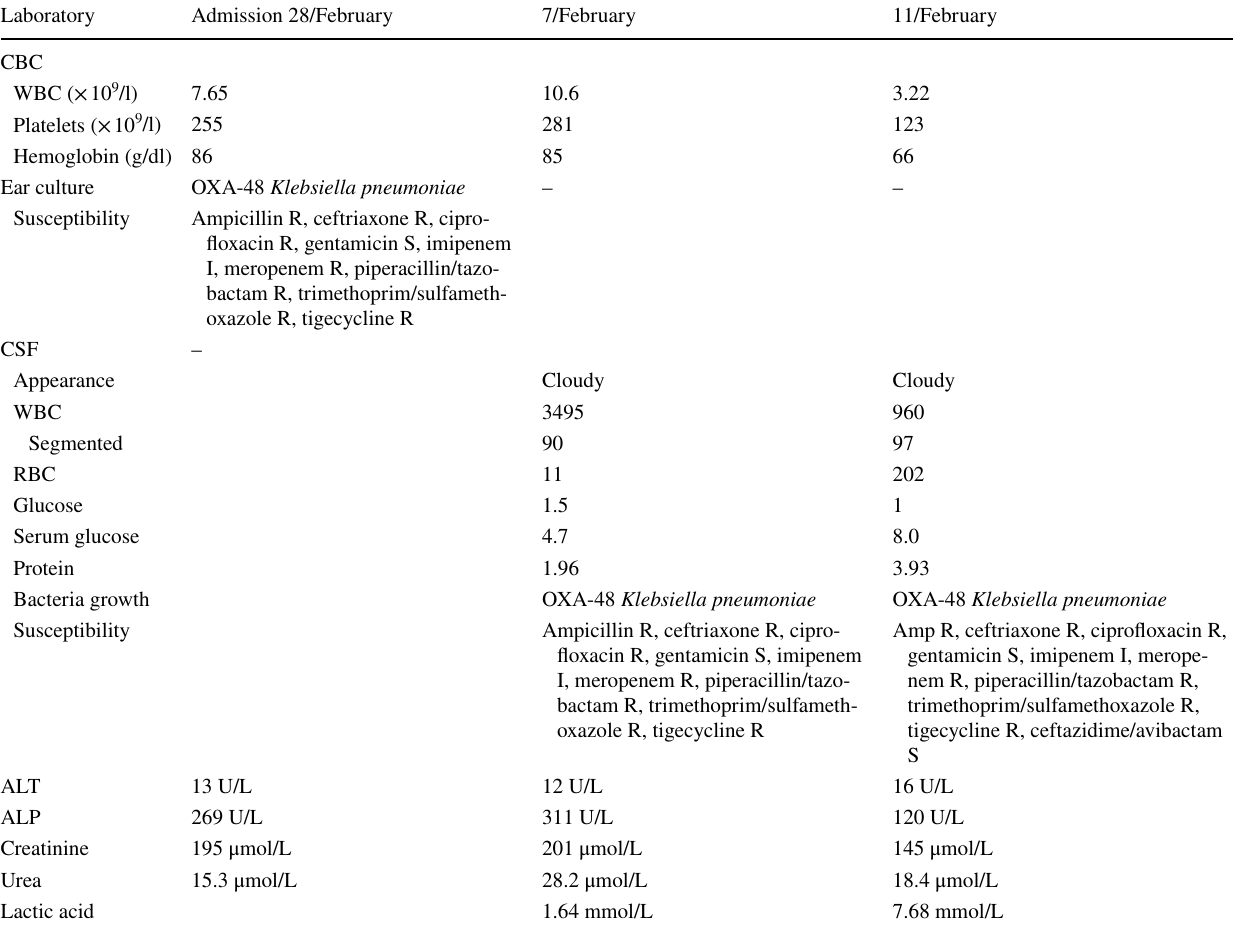
Table 1 Chronological order of key laboratory and microbiology tests